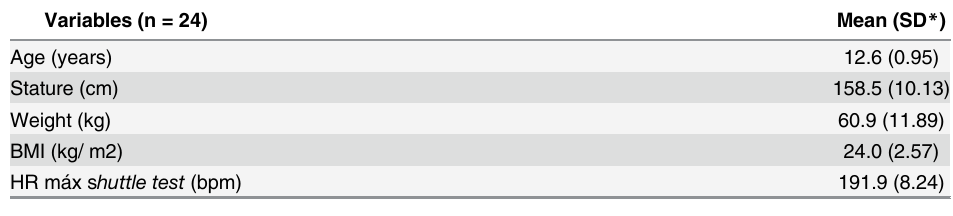
Table 1. Baseline characteristics of participants included in the study.